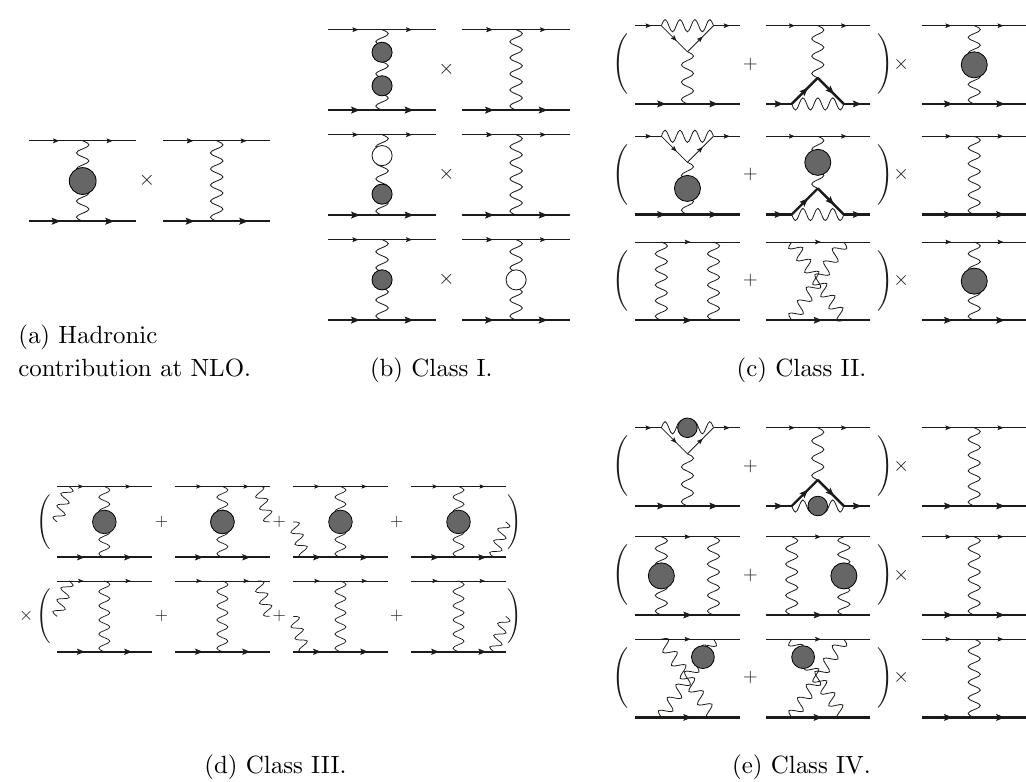
Figure 1. The hadronic contributions to (cid:22) - e scattering at NLO (a) and at NNLO (b-e). Muon and electron lines are drawn with thick and thin lines,